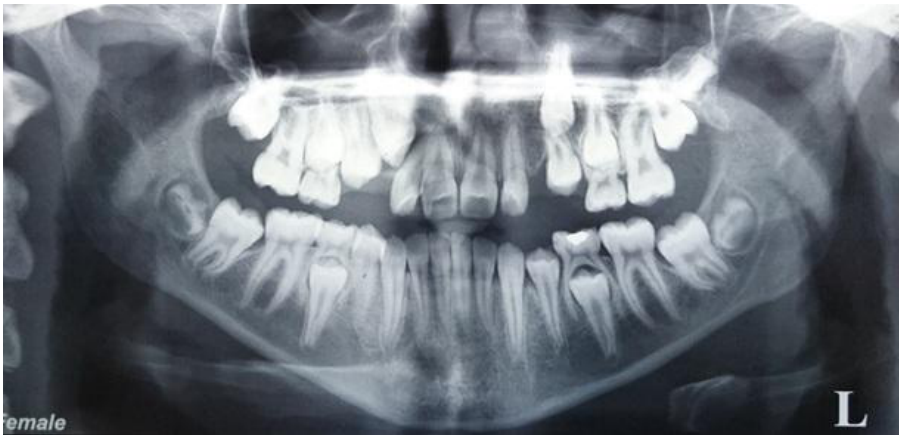
Figure 7. The panoramic view of the patient after five years follow-up at the age of